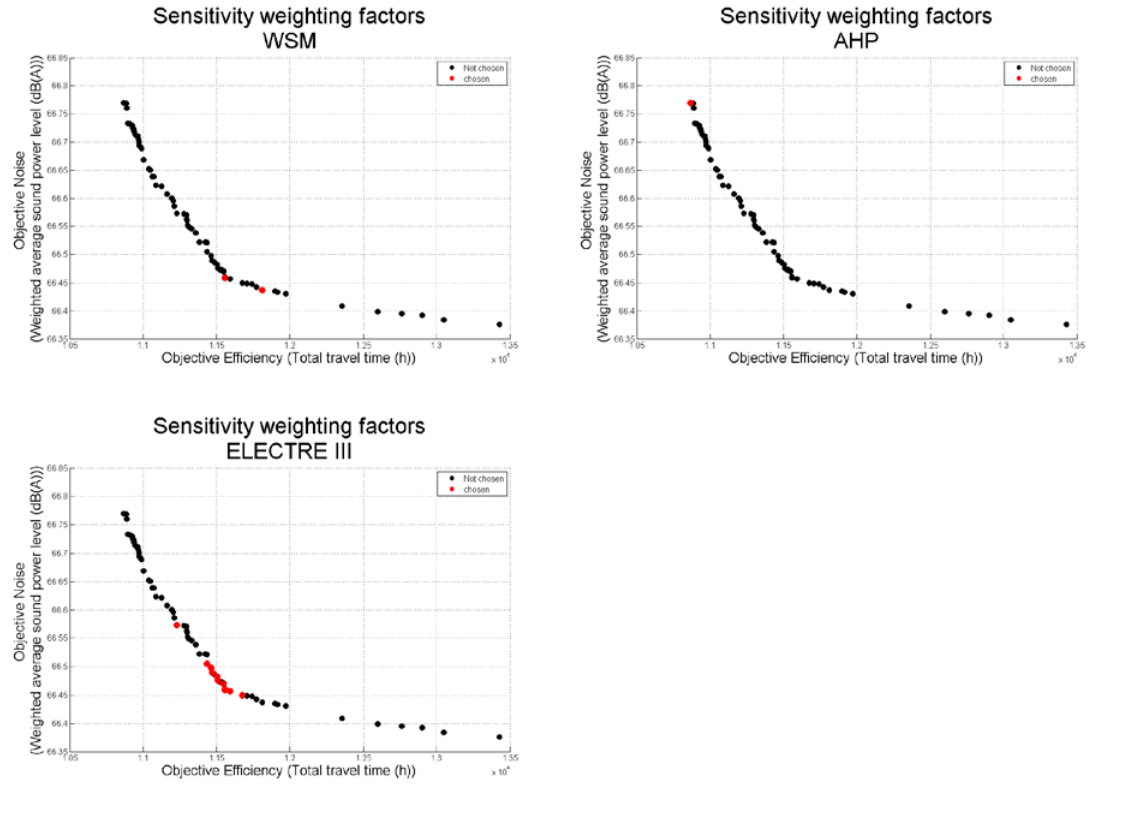
Figure 5. Sensitivity for weighting factors The ELECTRE III method relies less on the exact outcome of the solutions on the different objectives. This method is a fuzzy approach using certain thresholds for indifference, preference and veto. Therefore the ELECTRE III method is the only method that can also rank solutions not part of the convex hull (illustrated in Figure 6) as the best compromise solution. This method